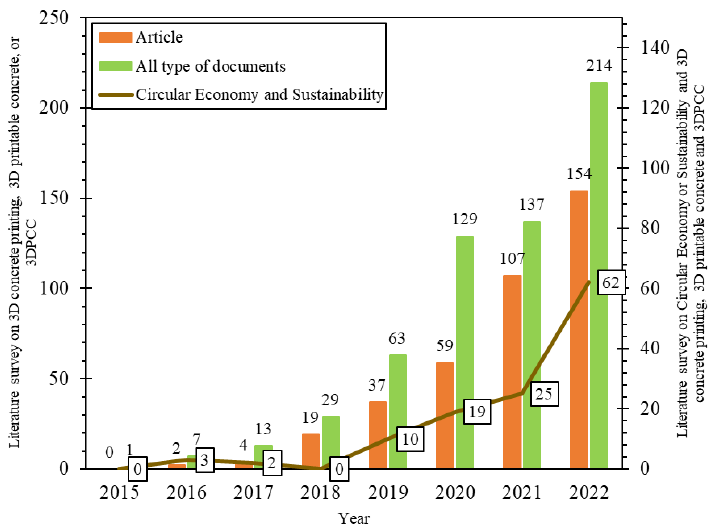
Figure 2. Number of documents published in English related to “3D concrete printing” or “3D printable concrete” or “3D printable cement-based composites” and literature on this topic related to “Circular Economy” or “Sustainability” (Data collected from Scopus in 26 December 2022).